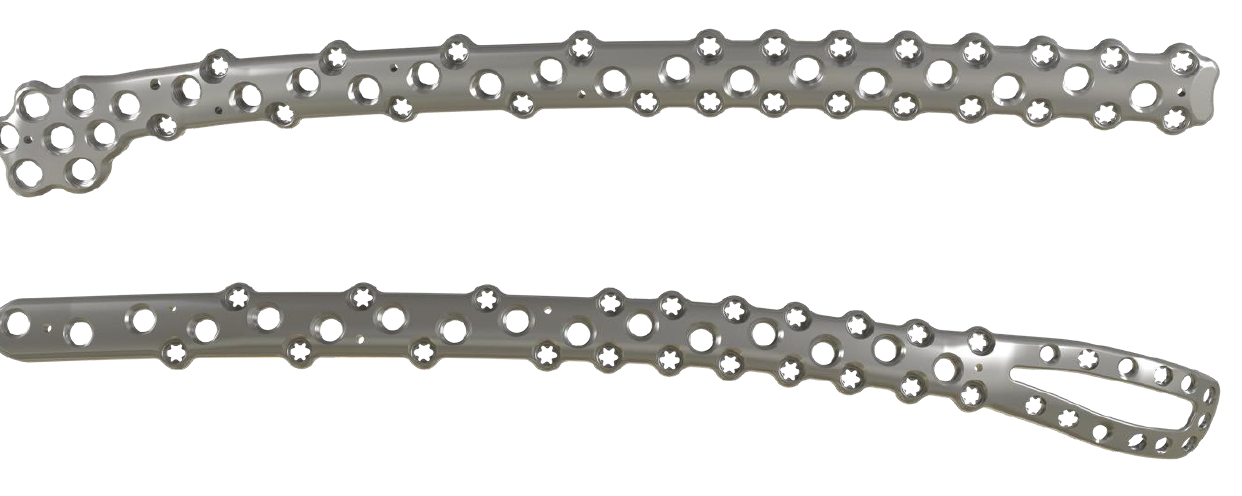
Figure 2. Distal and proximal plates of the EVOS Large & Periprosthetic Plating System by Smith & Nephew.